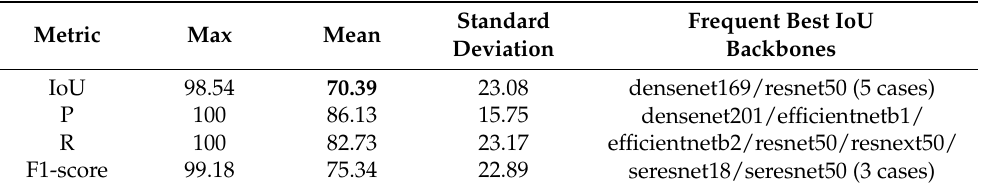
Table 4. Performance (%) of LinkNet on the test set after 5-fold cross-validation. Best IoU is marked in bold font.